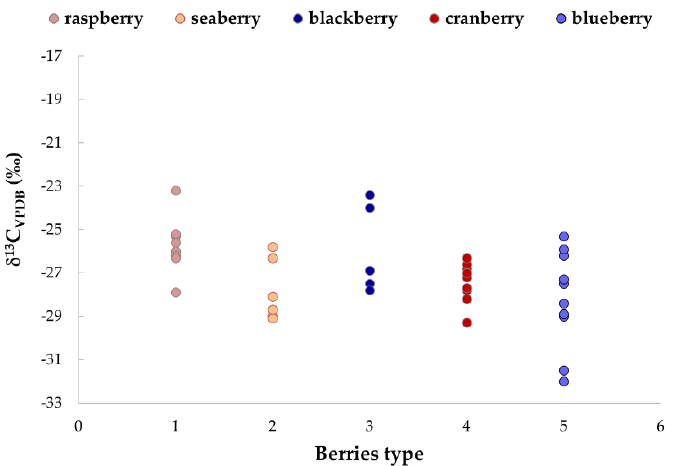
Figure 2. The 13 C signature of the investigated berries. Blueberries showed the lowest values (mean of − 2 8.2‰). The recorded values for blueberry samples are supported by the results of Perini et al. (2018) [8], who obtained lower values (mean of − 26.2 ‰ ) for blueberries coming from Eastern Europe (Romania and Poland) versus Italian blueberries ( δ 13 C = −24.2‰). These differences could be ex- plained by plant physiology processes and the agricultural practices used in growing re- gimes (open field, greenhouse) [28,29], taking into account that the 13 C isotopic signature of C3 terrestrial plants preserves valuable data related to: (i) internal physiologic charac- teristics, and (ii) changes in external environment that could influence carbon fixation dur- ing the photosynthetic process [30,31]. Table 1. Isotopic signature of 2 H and 18 O for studied samples. Berry